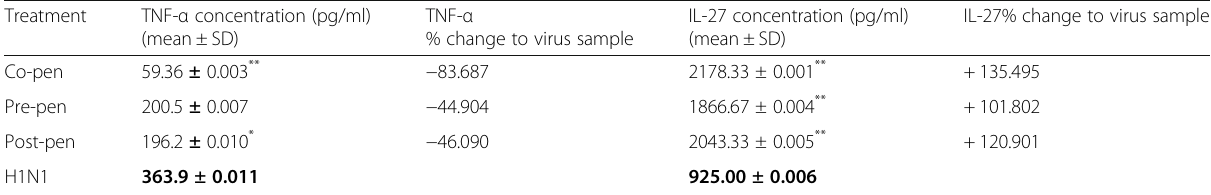
Table 3 TNF- α and IL-27 proteins concentrations in MDCK culture supernatants (pg/ml) at 48 h treatment